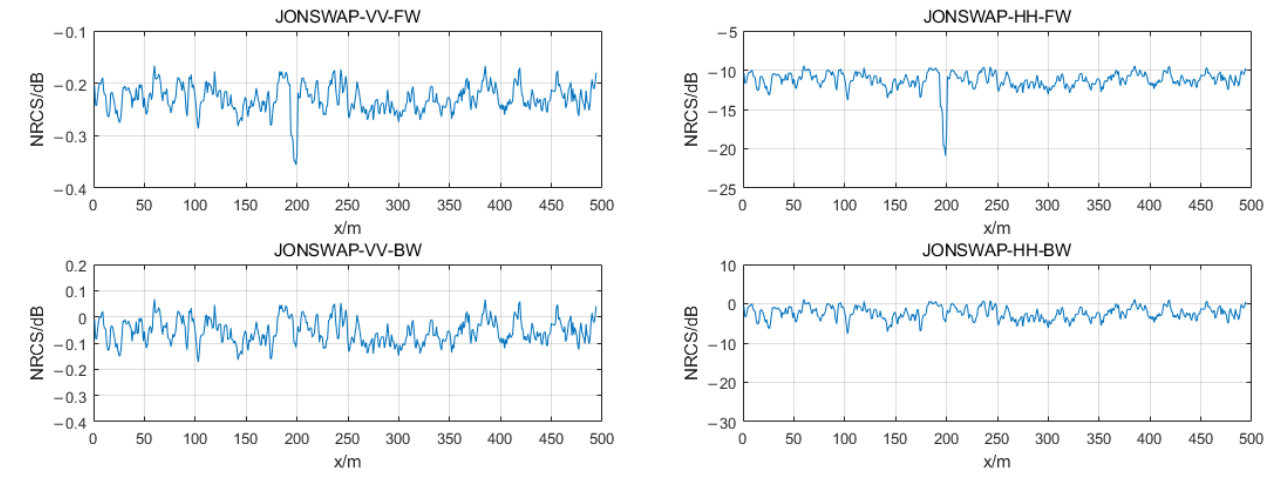
Figure 7. Comparison of NRCS results of freak wave (FW) and its background wave (BW) simulated by JONSWAP spectrum under VV polarization and HH polarization.